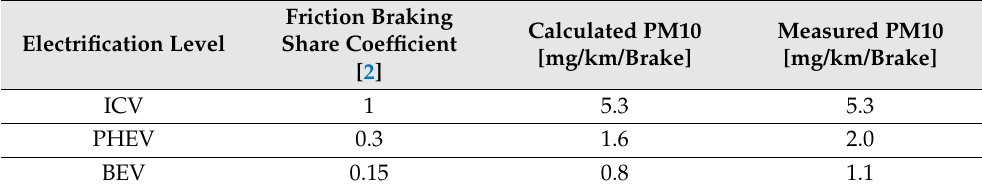
Table 11. Measured vs. calculated PM10 emission factors using friction braking share coefficients. Electrification